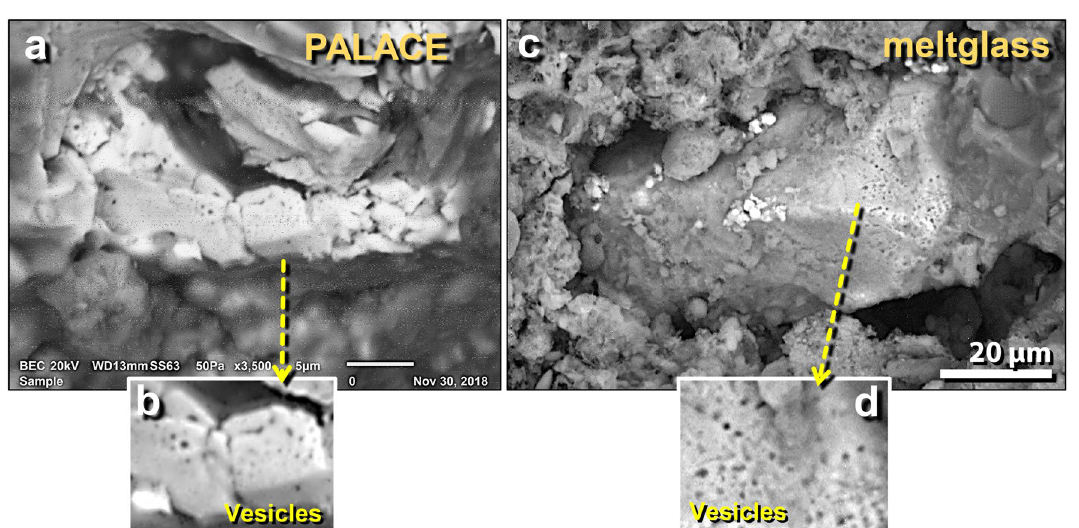
Figure 39. SEM images of melted iron and titanomagnetite in mudbrick meltglass from the palace. ( a ) Shattered elemental Fe grain containing < 0.1 wt.% oxygen as determined by SEM–EDS; ( b ) close-up showing surface porosity. ( c ) Titanomagnetite grain showing surface porosity; ( d ) close-up showing aligned porosity possibly along former grain boundaries. The cause of the porosity is uncertain, but because these grains are associated with other high-temperature melted minerals, we propose that this porosity resulted from exposure to high